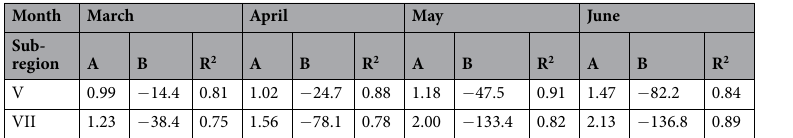
Table 7. The re-calibrated parameters A , B and R 2 in March, April, May and June for the V and VII sub-regions using Equation